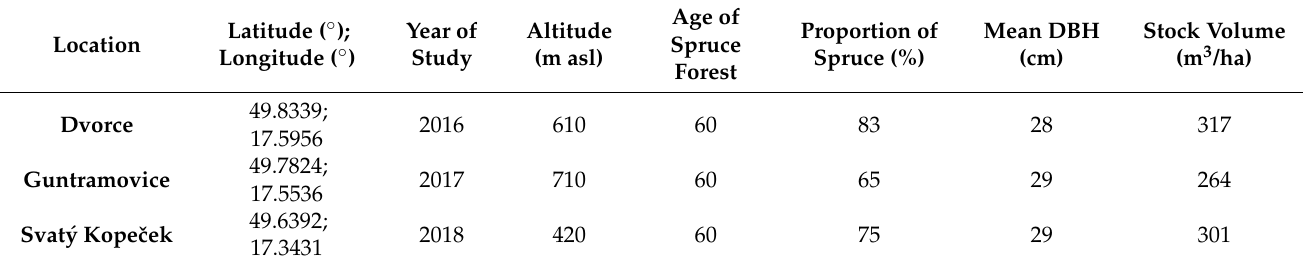
Table 1. Characteristics of studied